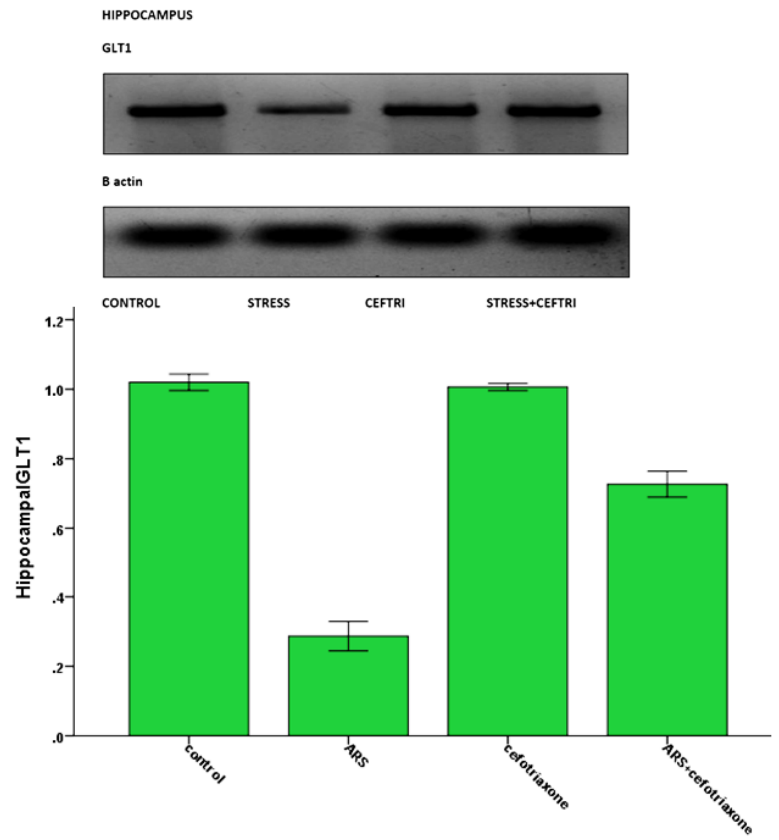
Figure 4. Western blot analysis of hippocampal glutamate transporter 1 expression in the studied Figure4. groups.